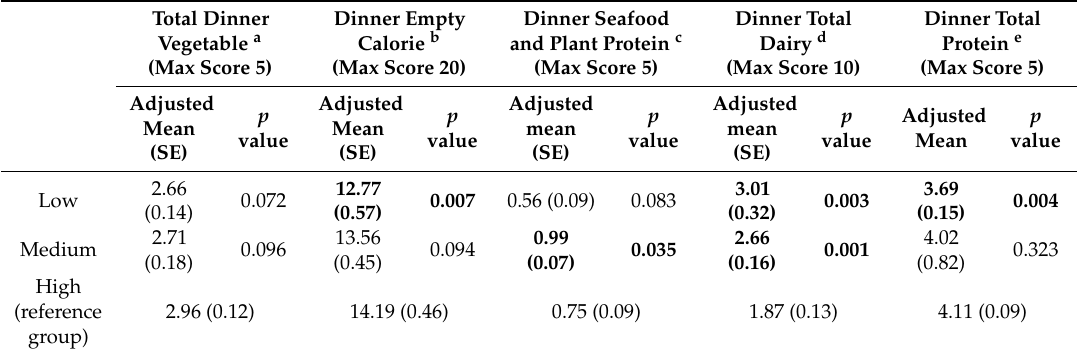
Table 5. Adjusted means from multiple linear regression models of dinner HEI total score and components and cooking frequency groups among Non-Hispanic Black adults ≥ 19 years of age: NHANES 2007–2010 (observations = 2027; weighted population =